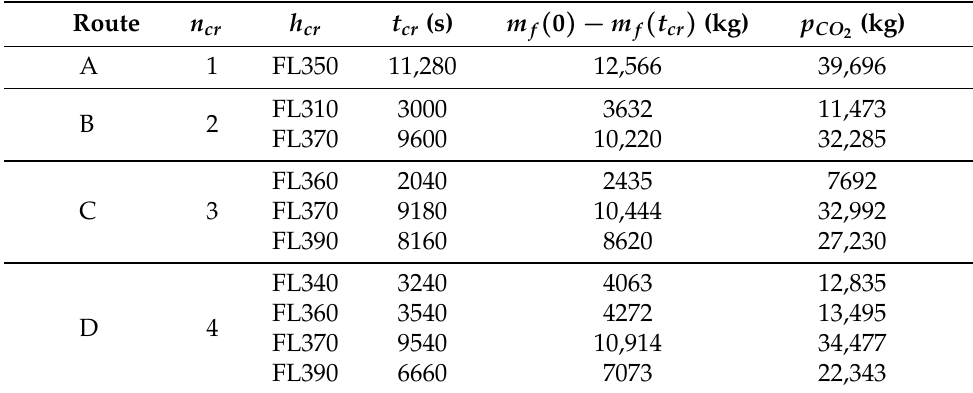
Table 3. Carbon dioxide emissions for four example